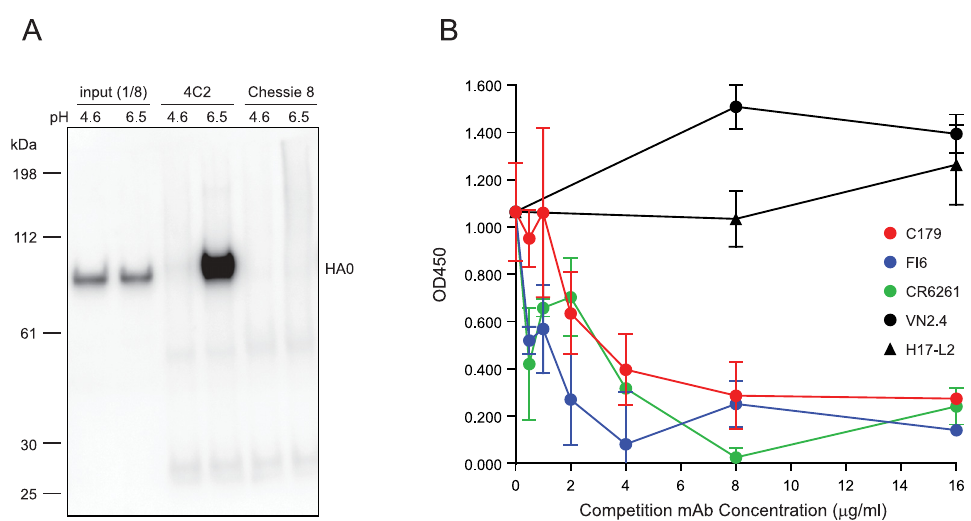
Fig 3. MAb 4C2 binds to HA with native conformation and recognizes the epitopes targeted by stem antibodies. (A) MAb 4C2 binds to HA with native conformation. A/New Caledonia/20/1999 (H1) HA-pseudoviruses (HAT was not included in HA-pseudoviruses production, and thus HA presented as HA0) were treated under different pH conditions, then immunoprecipitated with MAb 4C2 or Chessie 8, and analyzed by Western blotting with antiserum against H1 HA2. Input: 1/8 of total sample used for immunoprecipitation; MAb Chessie 8: Negative immunoprecipitation control. (B) Stem antibodies compete against MAb 4C2 binding to HA. MAb 4C2 binding to H5 HA was competed with HA head antibodies (VN2.4 and H17-L2) and stem antibodies (C179, FI6, and CR6261) in a competition ELISA. Data are shown as means and standard deviations.